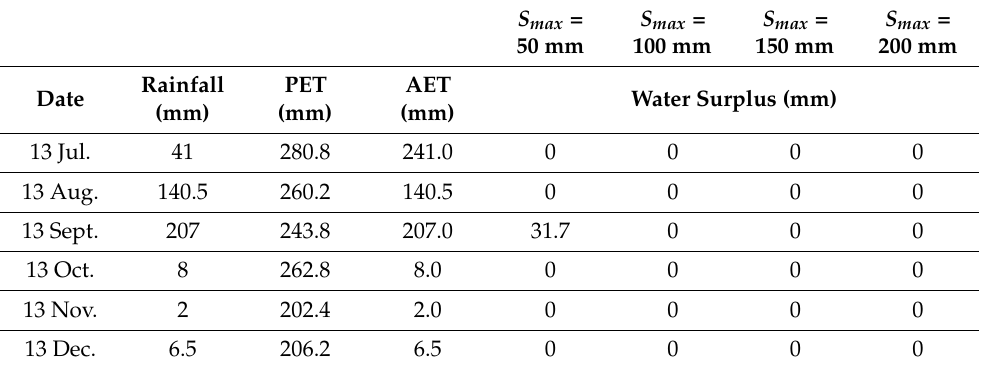
Table 1. Calculation results using the Thornthwaite method for year